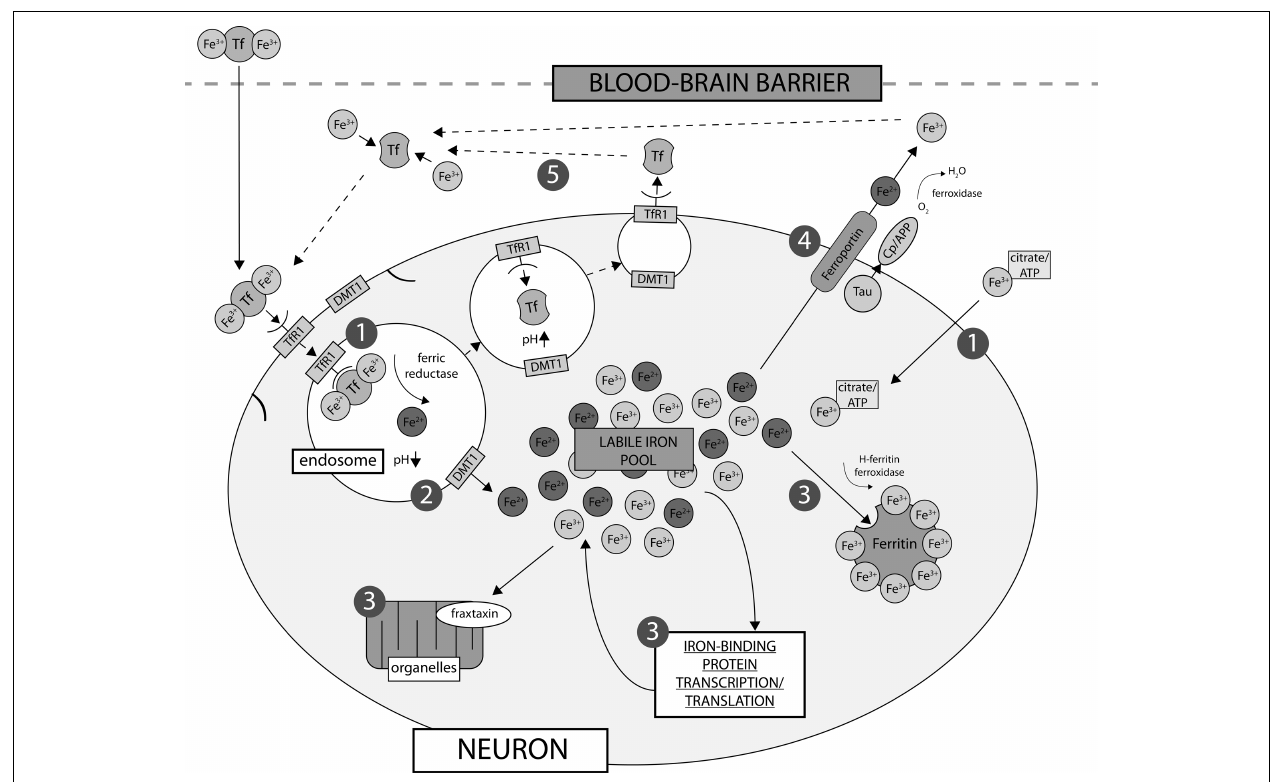
regulated by cellular metal sensing and iron-binding protein expression, including ferritin, which is the major iron storage protein in neurons (3). Export of iron from neurons is regulated by intramembrane ferroportin, which is stabilized via a mechanism involving tau and ceruloplasmin (Cp)/APP (4). Iron is then recirculated by apo-Tf